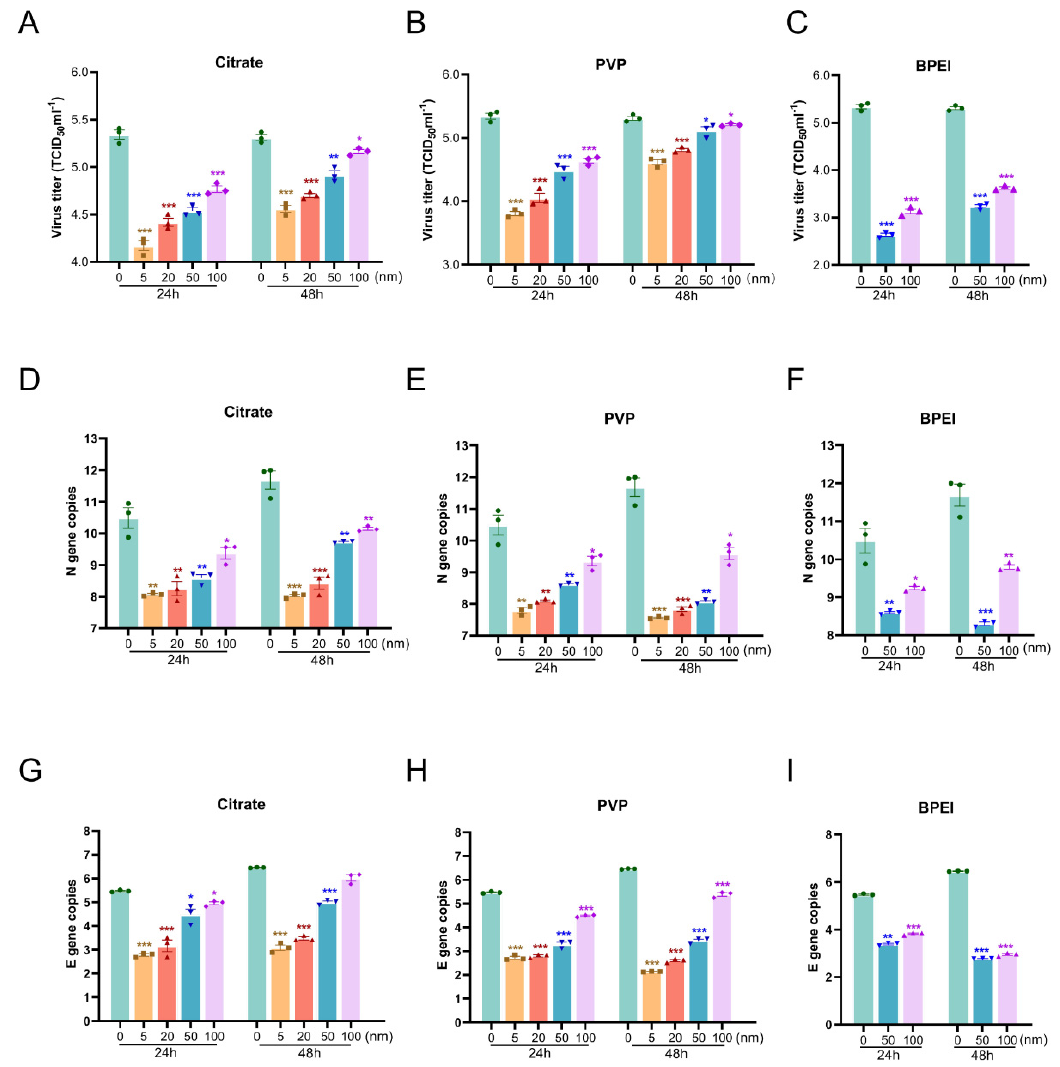
Figure 3. Effect of AgNPs on the replication of SARS-CoV-2 in Vero E6 cells. The cells were infected with SARS-CoV-2 (0.008 MOI). Vero E6 cells were treated with citrate, PVP, and BPEI coated AgNPs, with different particle sizes. The cell supernatant was collected at 24 and 48 h to detect the virus titer and the copy number of the virus genome. ( A – C ) Effects of different treatment times and particle sizes on SARS-CoV-2 virus titer of Citrate ( A ), PVP ( B ), and BPEI ( C ), respectively. ( D , E ) Effects of Citrate ( D ), PVP ( E ), and BPEI ( F ) with different particle sizes on the number of copies of the SARS- CoV-2 N gene, respectively. ( G – I ) effects of Citrate ( G ), PVP ( H ), and BPEI ( I ) with different particle sizes on the number of copies of the SARS-CoV-2 E gene, respectively. Three experiments were con- ducted (n = 3 group), * p <0.05, ** p < 0.01, *** p < 0.001.